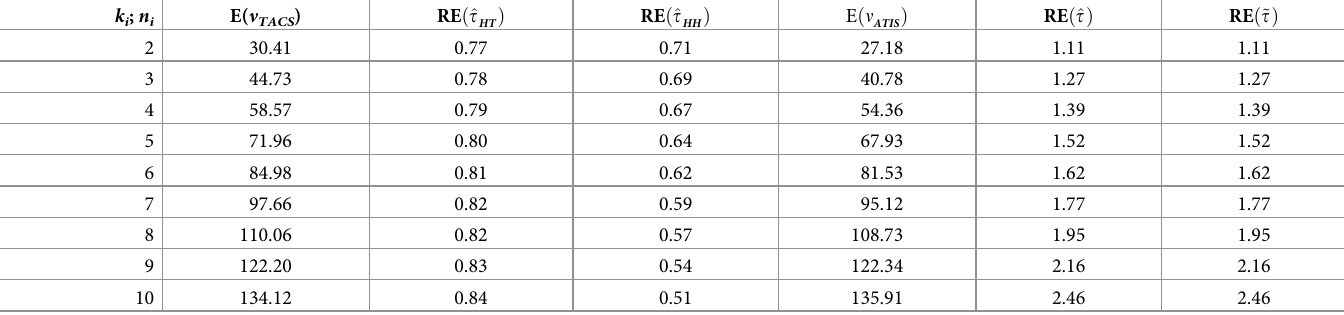
Table 4. The relative efficiencies of ^ t and ~ t for ATIS and, those of ^ t The relative efficiencies of ATIS and TACS are computed for m = 12, c = 0, with k i = 2, 3, ... , 10 for ATIS, and with n i = 2, 3, ... , 10 for TACS. For ATIS estimators, the rel- ative efficiencies are calculated based on the effective final sample sizes of ATIS, E ð n final sample sizes of TACS, E( ν TACS